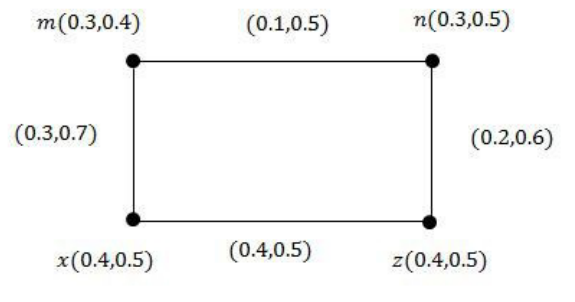
Figure 2. Strongly Irregular Vague Graph (SIVG) ( G ).